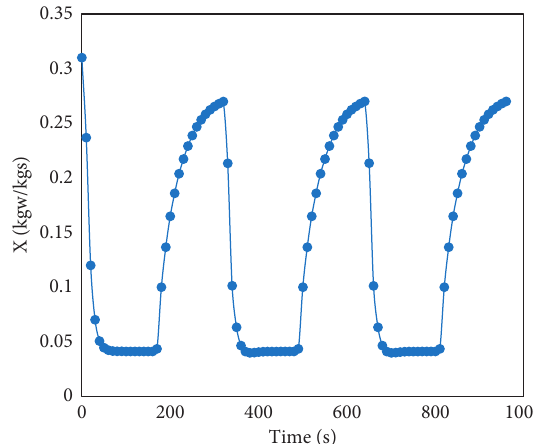
Figure 2: Variation of average adsorption uptake ( X ) with